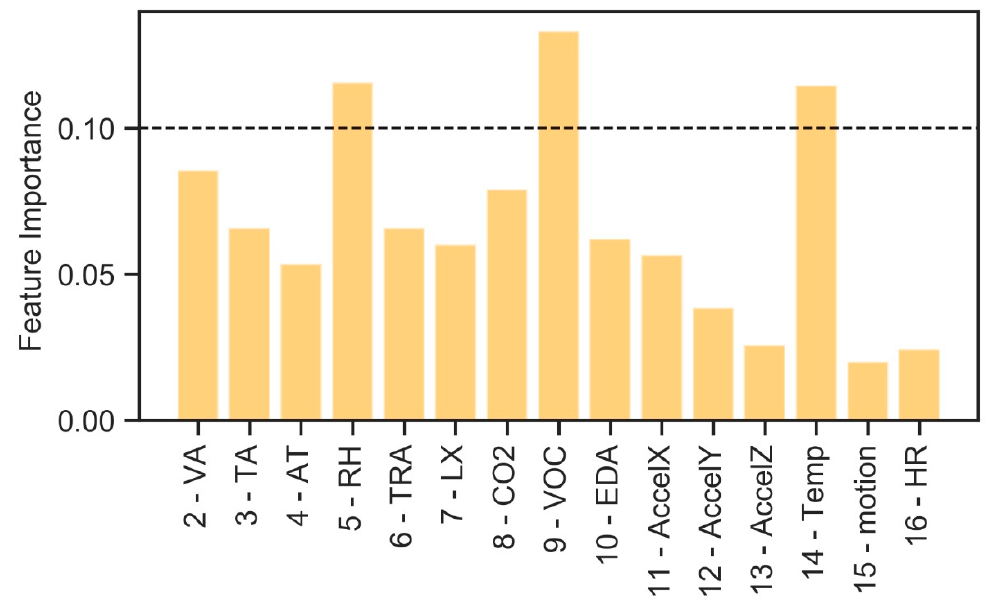
Figure 9. Feature importance—environmental and biometric data for user identification.